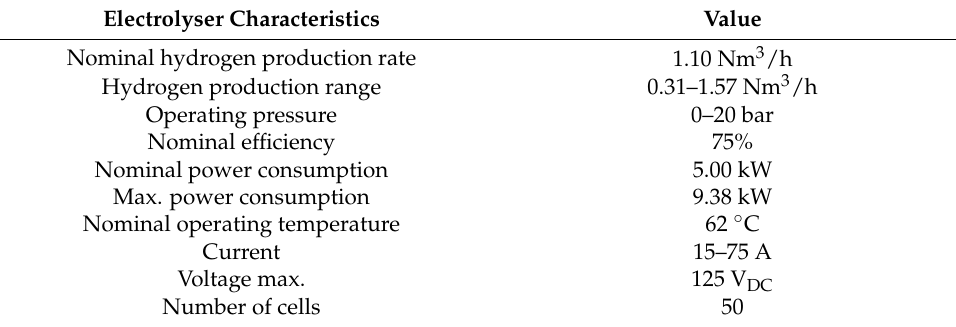
Table 2. Electrolyser characteristics (Type: H-Tec S30/50).